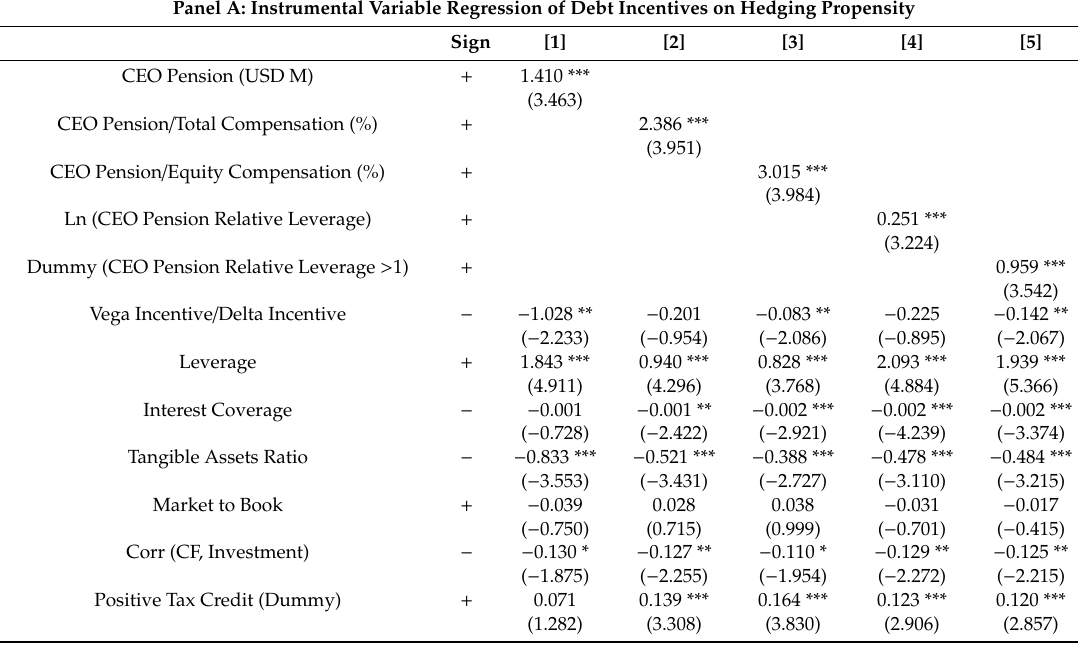
Table 5. Instrumental variables